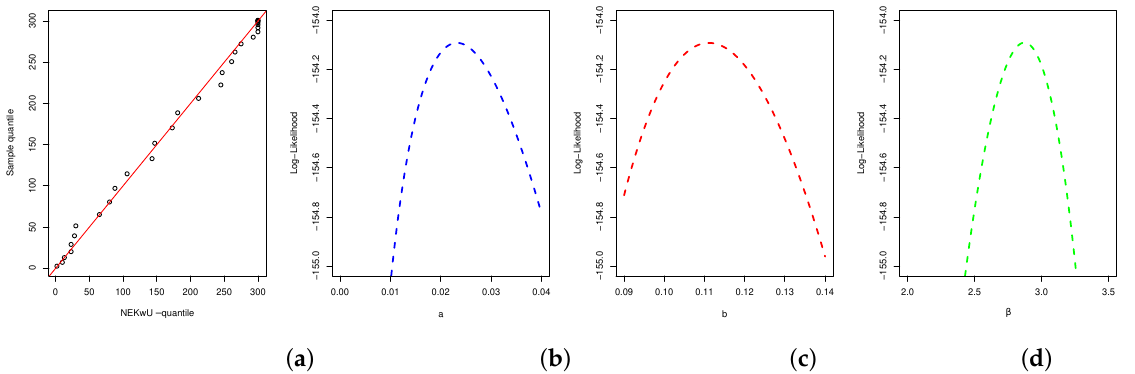
Figure 5. ( a ) QQ plot of the NEKwU model and ( b – d ) plots of the profile log-likelihood of the NEKwU model for the first data set, for a , b , and β ,